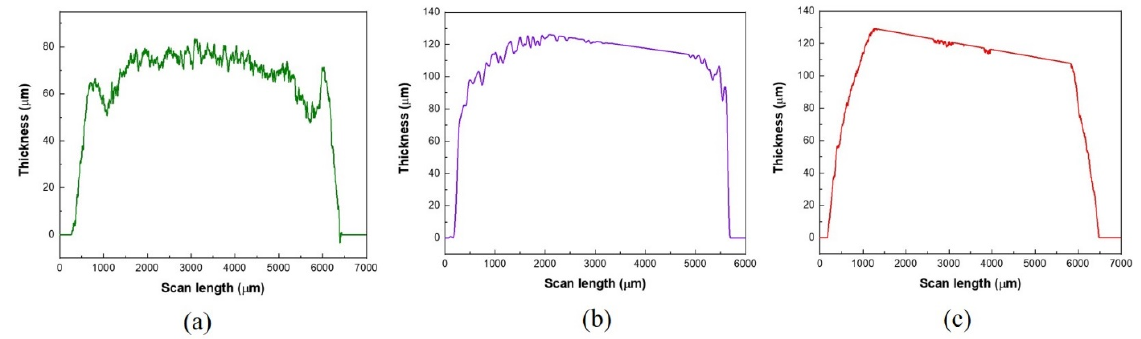
Figure 4. Thickness profiles of the printed ( a ) carbon current collector layer, ( b ) silver oxide layer, and ( c ) zinc layer.